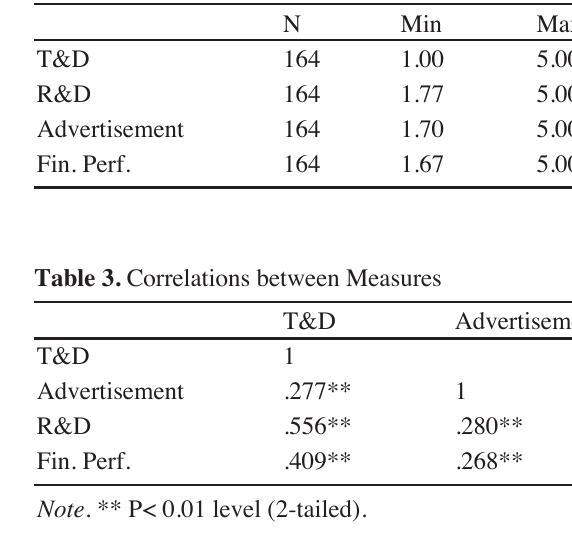
Table 2. Descriptive Statistics